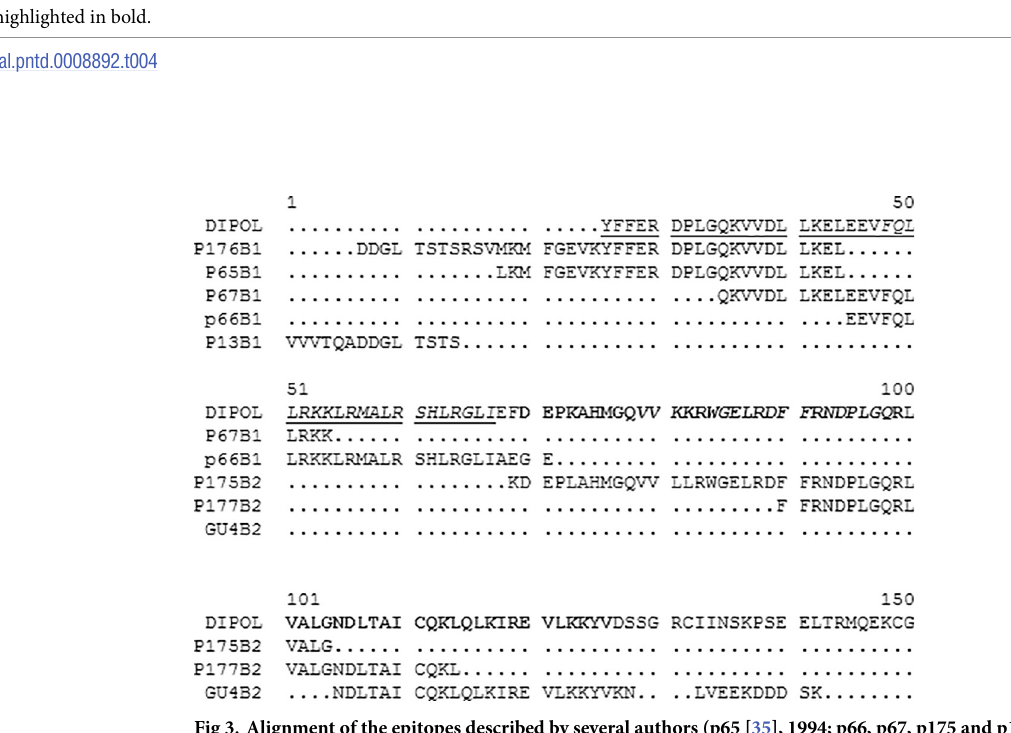
1 P-values estimated through multivariable logistic regression accounting for the potential confounding due to all variables presented in the table. The multivariable analysis was conducted on 203 and 187 patients with data available for all variables included into the models for HF-Elisa and other ELISAs, respectively. Statistically significant differences are highlighted in bold.